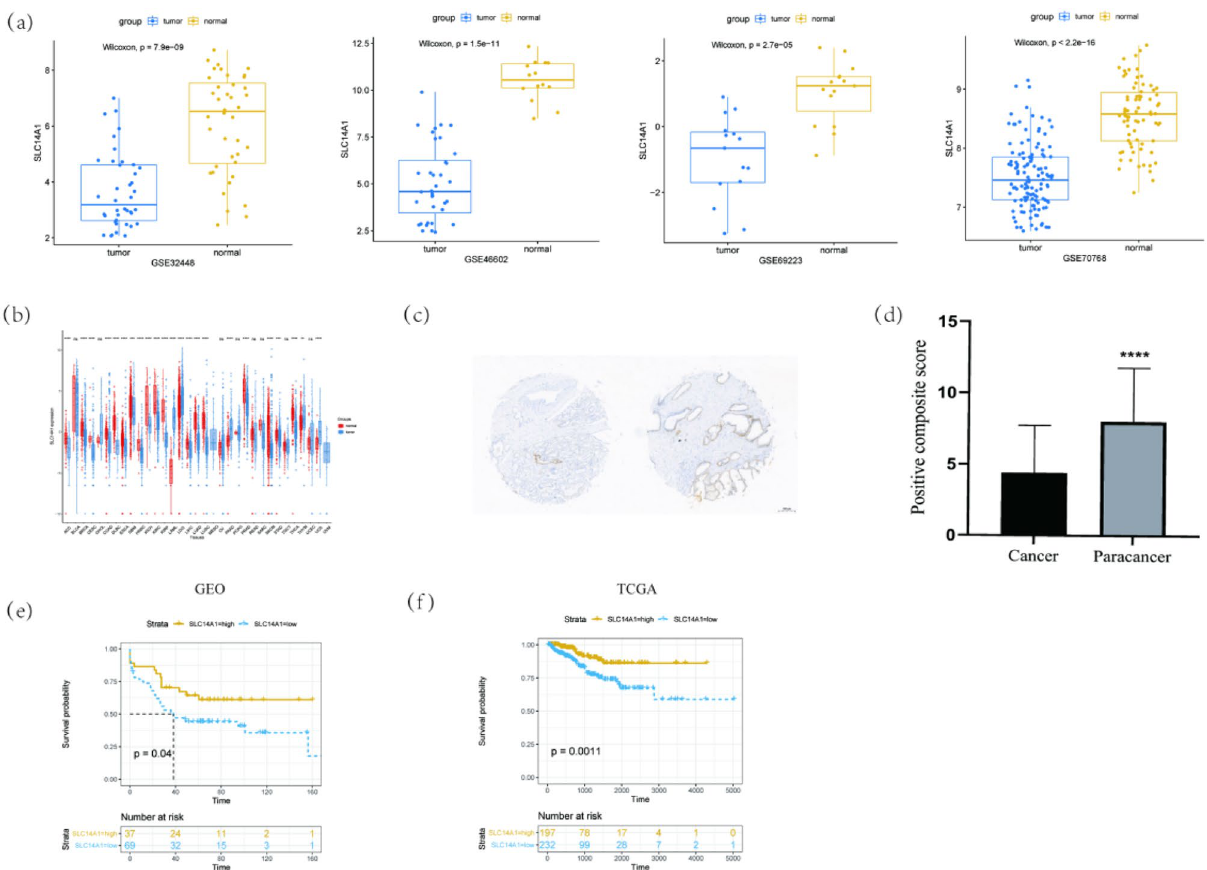
GSE32448, GSE46602, GSE69223, and GSE70768. ( b ) Comparison of the transcripts per million (TPM) value of SLC14A1 expression in other tumors and normal tissue. TPM values were obtained from TCGA datasets. ( c